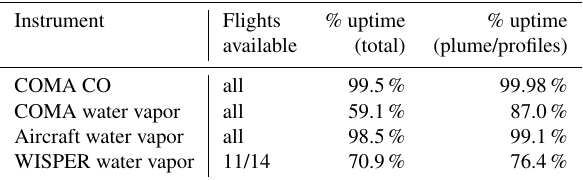
Table 1. Data availability from each in situ instrument, as a percent- age of all flight time (takeoff to landing), 30 August–27 Septem- ber 2016, and as a fraction of only the in-plume level leg or ver- tical profile flight time (40% of total flight time). A large portion of instrument downtime was during transit periods above the plume